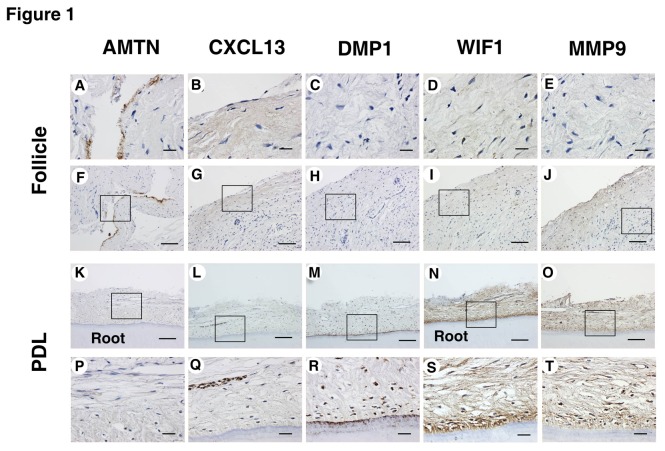
Immunohistochemical (IHC) staining of dental follicle and permanent PDL tissues.(A, F) IHC staining for AMTN in the dental follicle and (K, P) permanent PDL tissues. (B, G) IHC staining for CXCL13 in the dental follicle and (L, Q) permanent PDL tissue. (C, H) IHC staining for DMP1 in the dental follicle and (M, R) permanent PDL tissue. (D, I) IHC staining for WIF1 in the dental follicle and (N, S) permanent PDL tissue. (E, J) IHC staining for MMP9 in the dental follicle and (O, T) permanent PDL tissue. (Scale bars: 20 μm in A–E and P–T; 100 μm in F–O.)